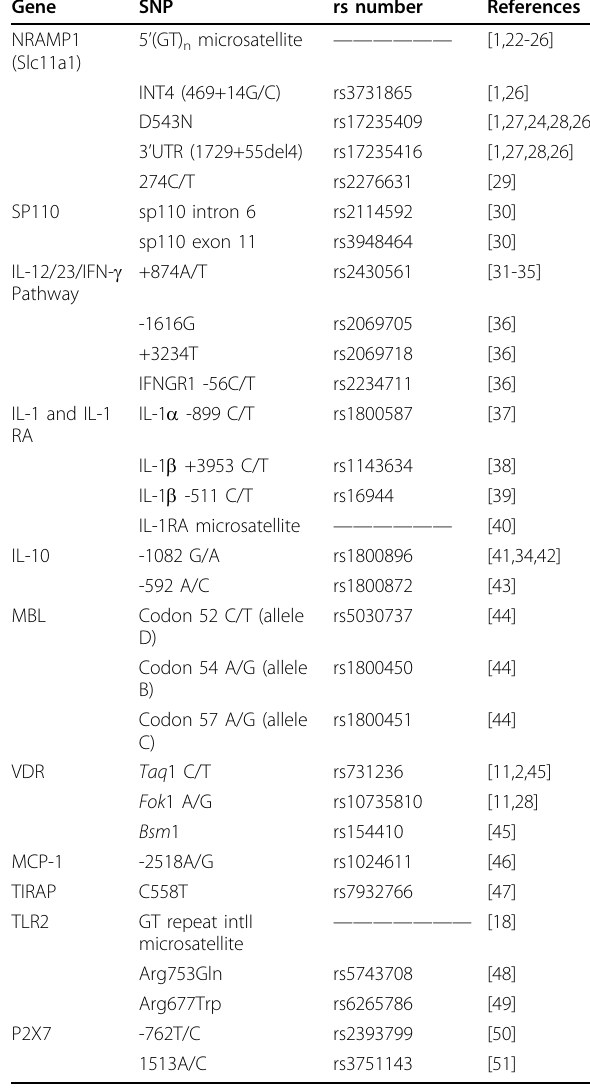
Table 2 Polymorphisms Tested that had Previously Been Reported as Associated with Tuberculosis